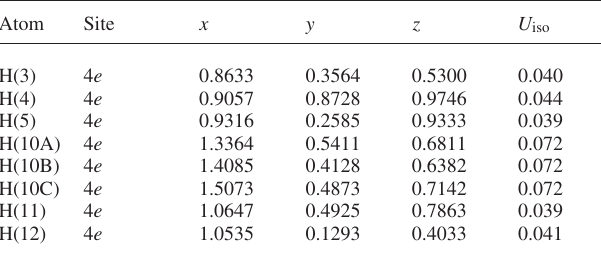
Table 2. Atomic coordinates and displacement parameters (in Å 2 ) .